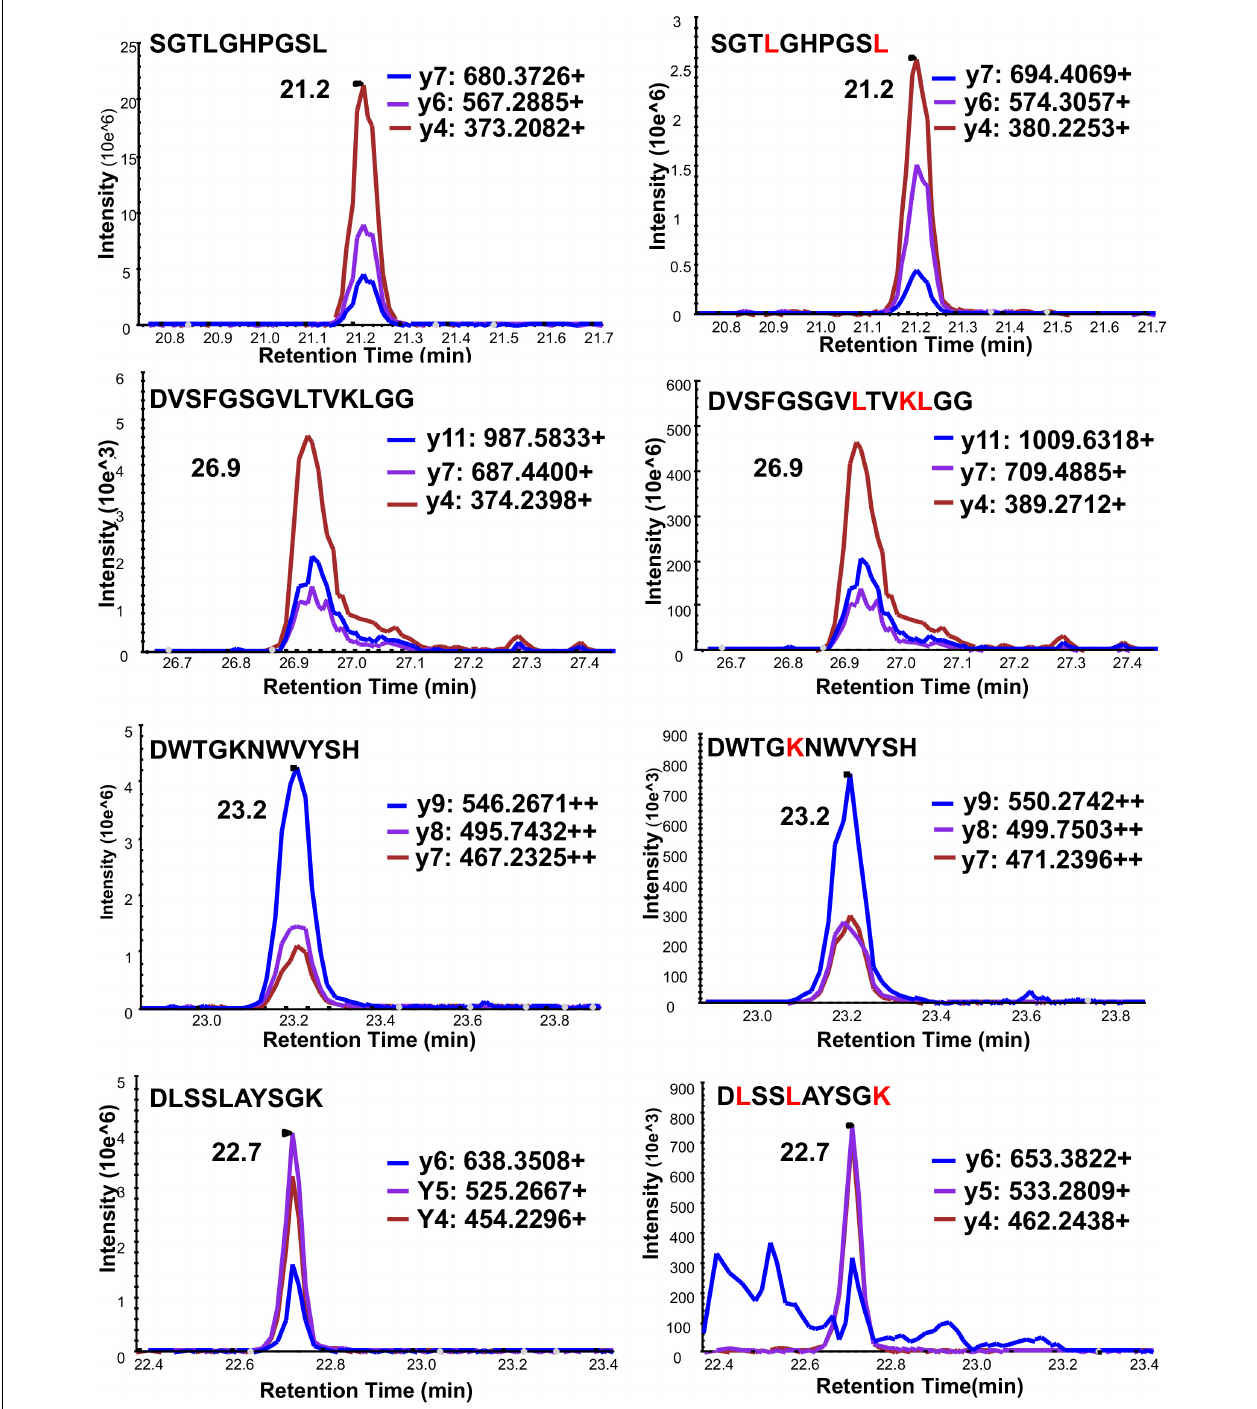
FIGURE 3 | Typical chromatograms of three PRM ion transitions of four quantitative Asp-N peptides under PRM mode. Left panel is light peptide, right panel is heavy peptide. Y -axis is response intensity under PRM mode. X -axis is retention time (min). Three PRM transitions shown in blue, purple and red.